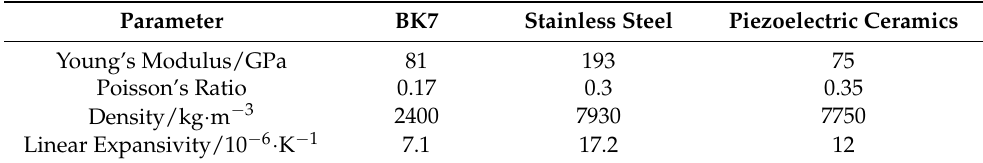
Table 3. Material parameters of the DM.